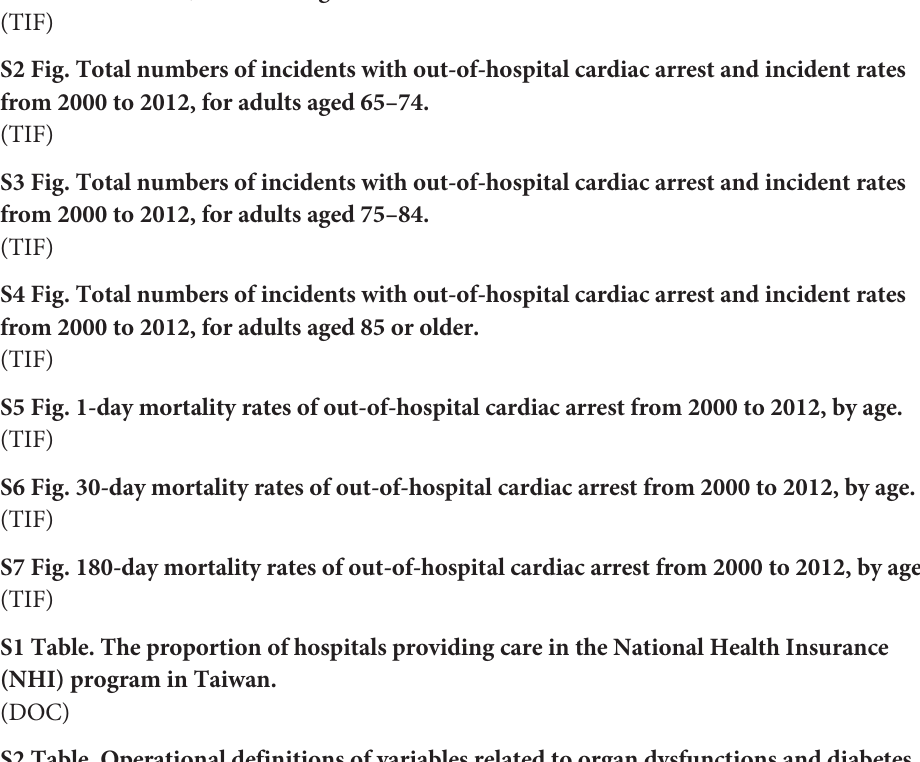
S2 Fig. Total numbers of incidents with out-of-hospital cardiac arrest and incident rates